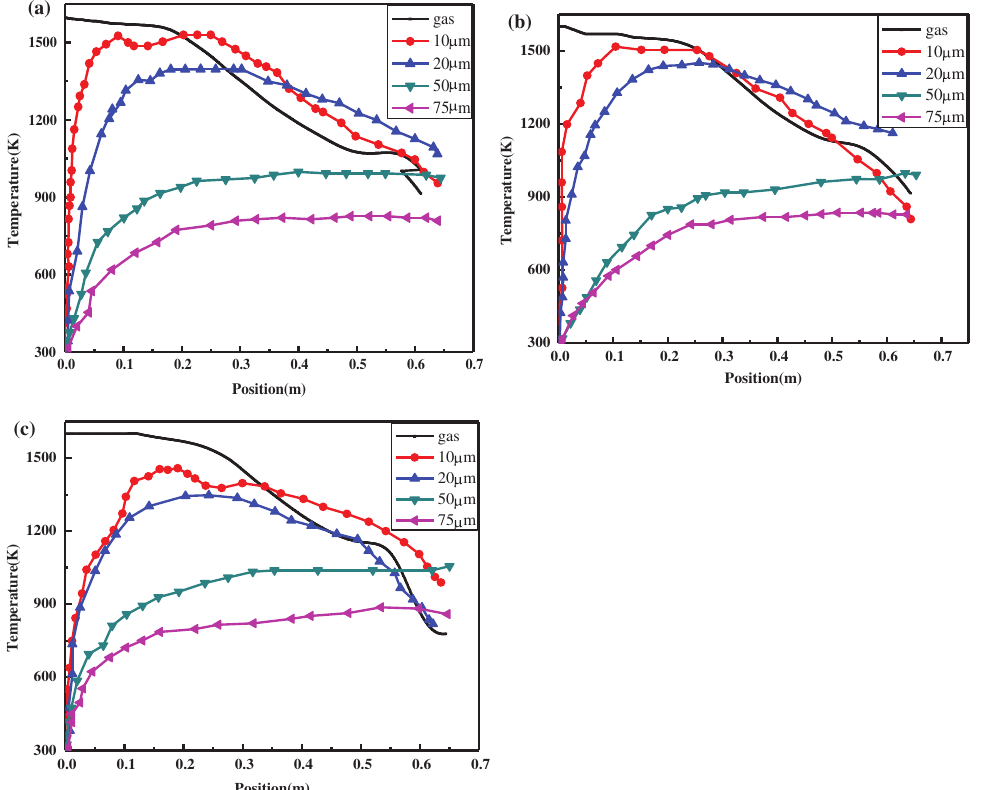
Figure 6: Gas temperature versus to particle temperature for different size particles at different Mach numbers: (a) Mach 0.3, (b) Mach 0.5 and (c) Mach 0.9.